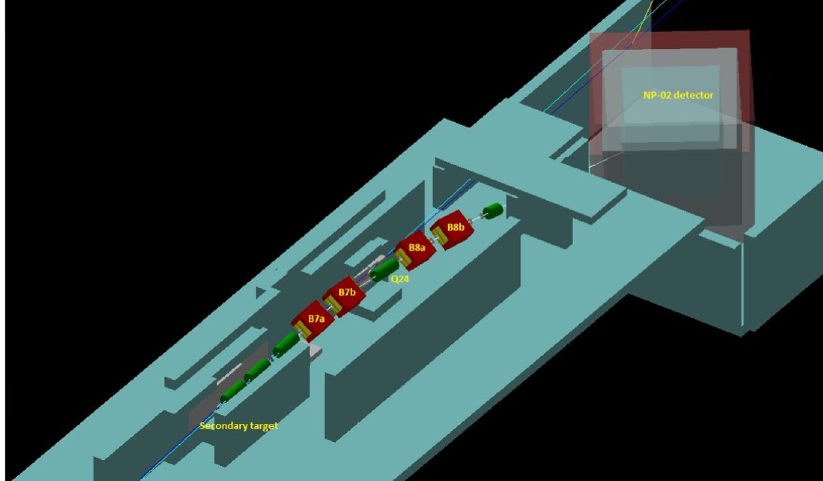
FIG. 10. G 4 B eam L ine ® model of the H2-VLE beam line. The green shapes correspond to the quadrupoles, the red ones in the bending dipoles. The secondary target and acceptance quadrupoles are shown inside the shielding bunker and not visible. The dump absorbing the secondary particles is located next to the field-lens quadrupole (Q24). The model of NP-02 detector is shown on the right. (Courtesy: M. Rosenthal and N. Charitonidis)